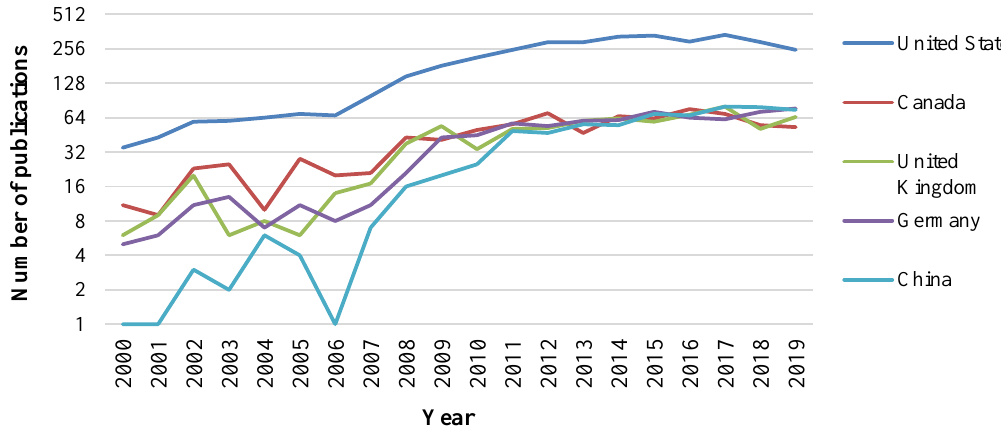
Figure 5. Top five contributors in the last 20 years. The y -axis is represented in log 2 scale.